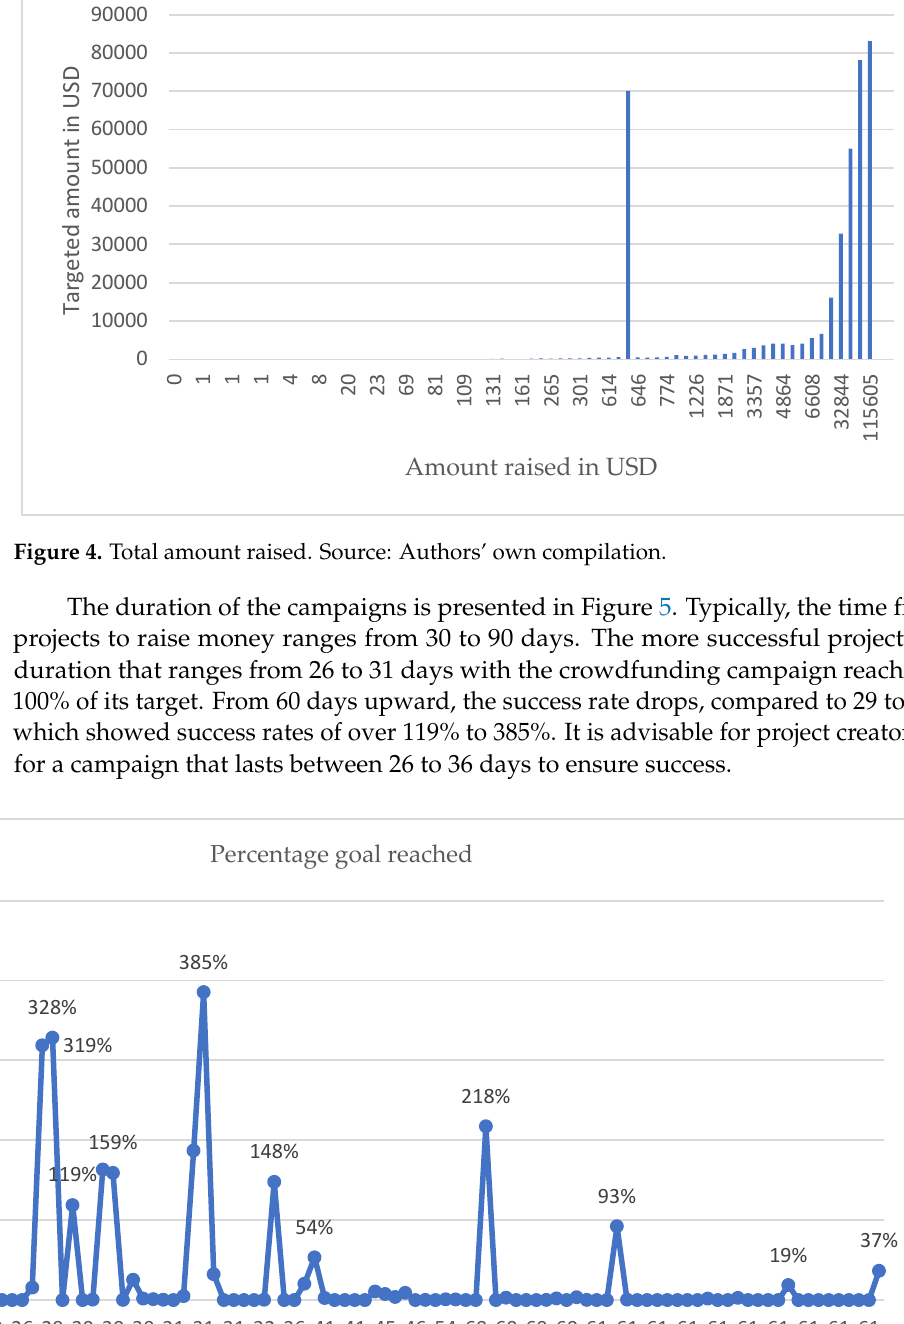
11 of 18 Figure 3. Percentage of goal reached per crowdfunding category.